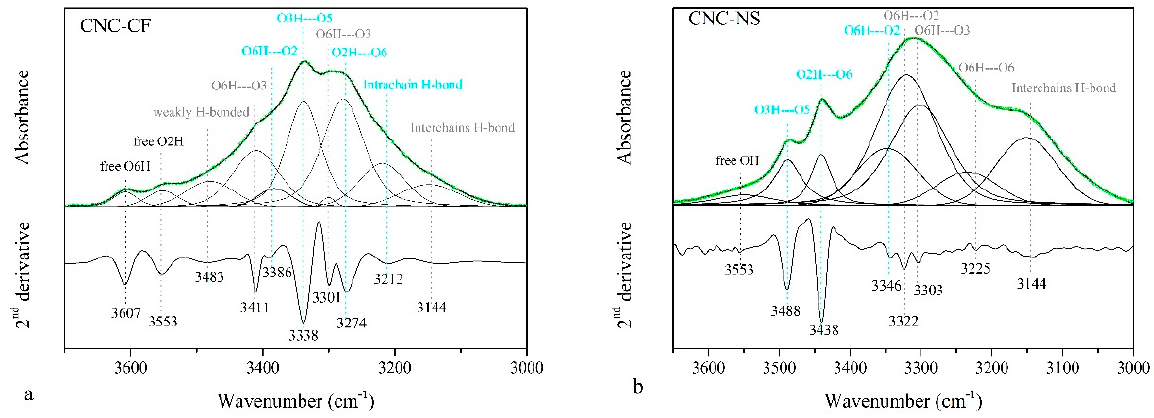
Figure 8. Deconvolution of the FTIR spectra and second derivative of ( a ) CNC-CF (polymorph I β ) and ( b ) CNC-NS (polymorph II) in the 3700–3000 cm − 1 region. The cyan and light gray colors refer to intra- and intermolecular H-bonds, respectively.